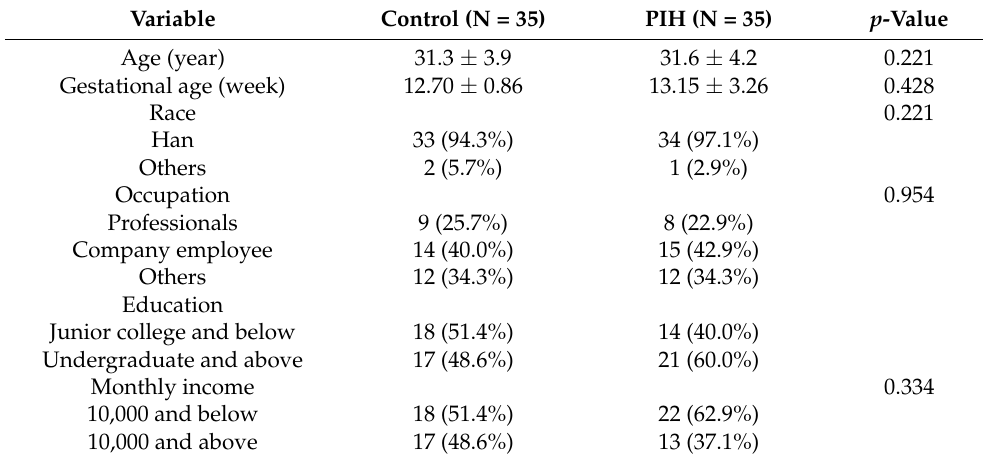
Table 1. Basic characteristics of subjects.